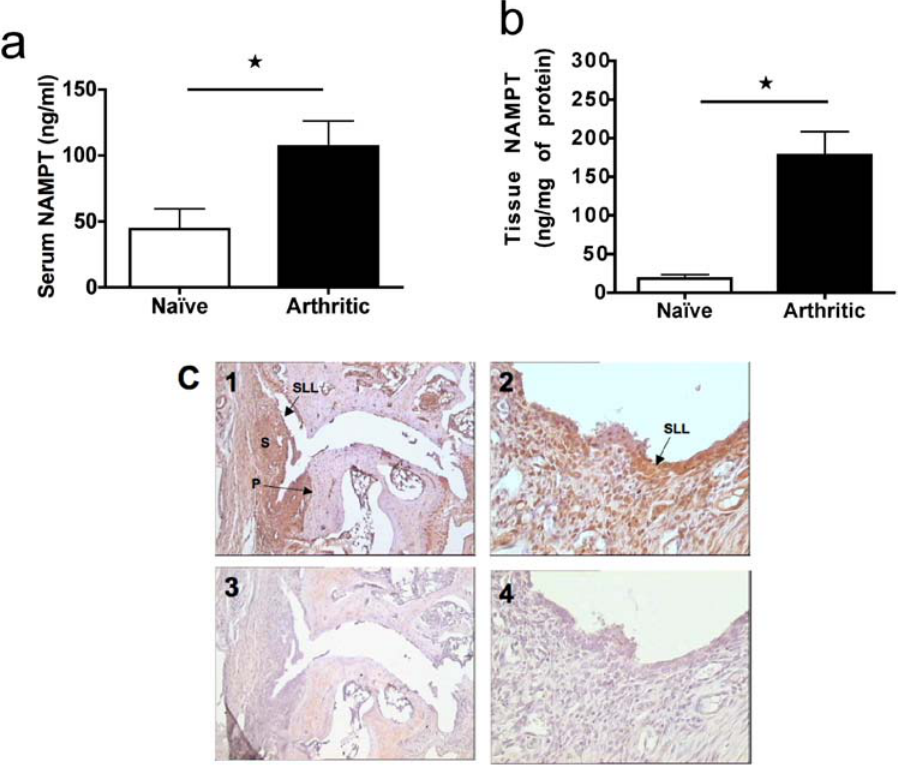
Figure 1. Induction of NAMPT expression in collagen-induced arthritis. Sera (a) and tissue extracts of paws (b) from CIA at day 14 (n=8) and from non-arthritic, non-immunized, naı¨ve (n=7) mice were prepared and analyzed by NAMPT ELISA. * P , 0.05 arthritic versus naı¨ve in panel a and b. (c) NAMPT immunohistochemistry was performed on paw joints, using a specific rat anti-mouse NAMPT antibody (panels 1 and 2). Staining specificity was confirmed using an irrelevant isotype-matched antibody as primary antibody (panels 3 and 4). Synovial lining layer (SLL), synovial membrane (S) and pannus (P). Original magnifications: x100 for panels 1 and 3; x400 for panels 2 and 4.